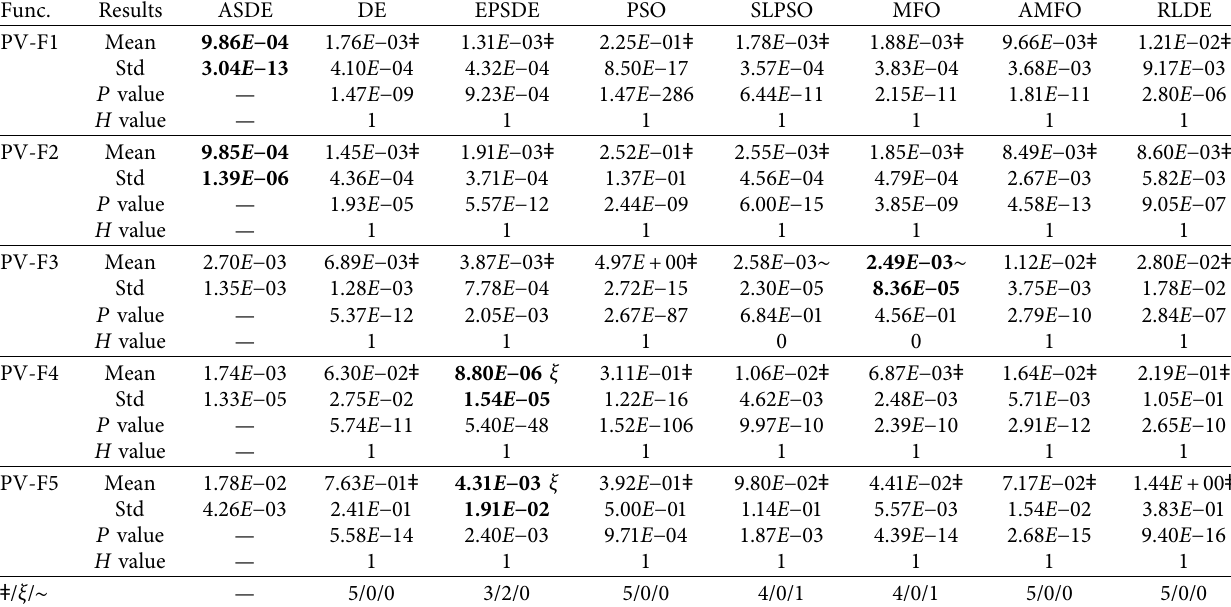
Table 6: Solution accuracy of ASDE and compared algorithms on PV problems.